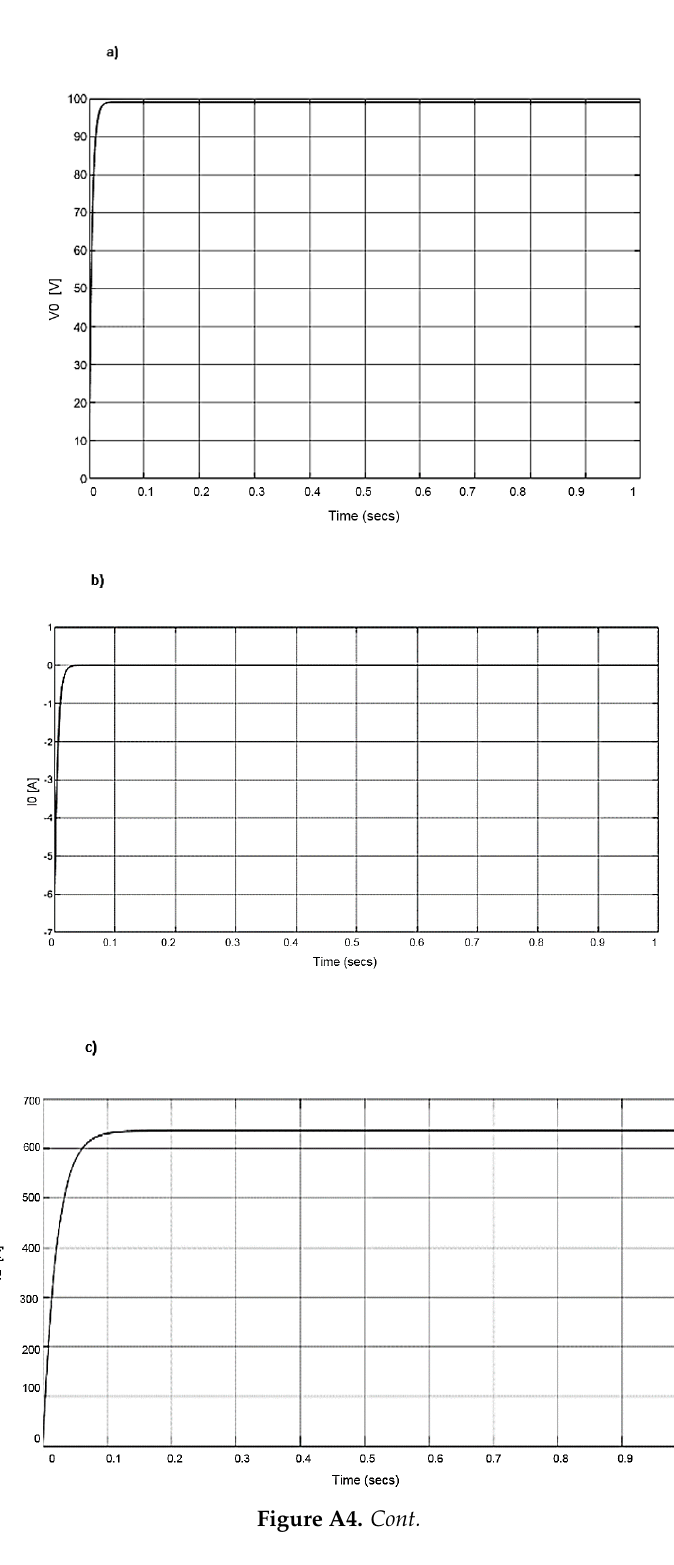
Figure A3. The courses of voltage V 0 , currents I 0 , IL , and voltages V c , V d , and V s versus time for the